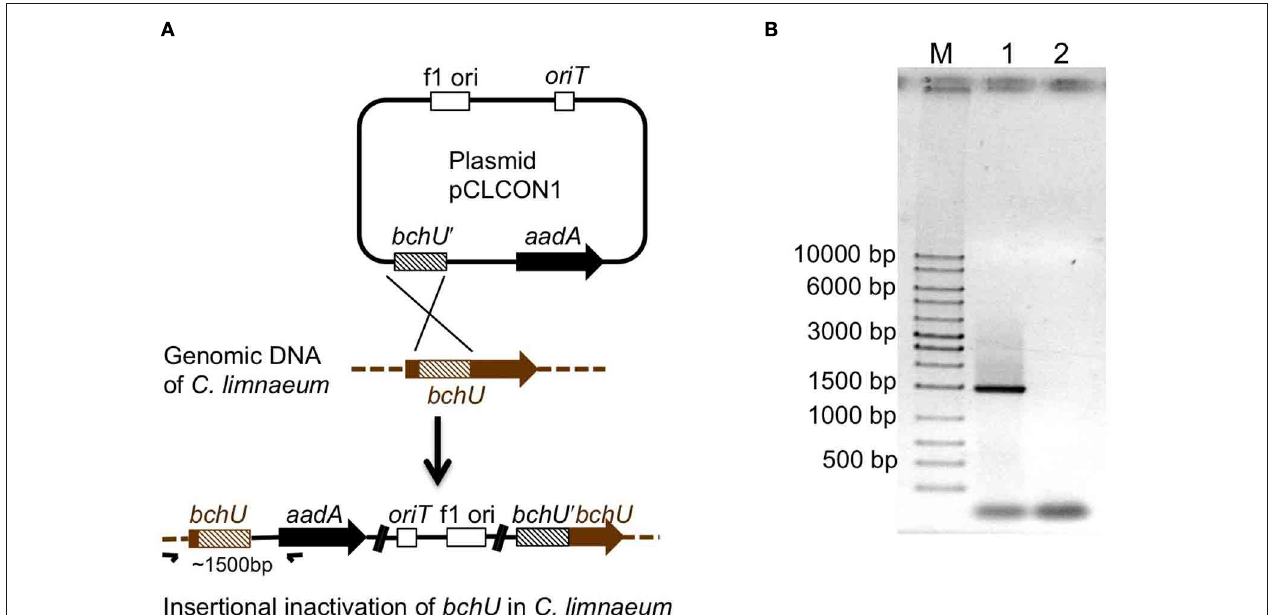
FIGURE 2 | (A) Schemeshowingthegeneralfeaturesandthearrangementin suicideplasmid pCLCON1andhowasinglecross-overrecombinationevent betweenthegene-internalfragmentof bchU ( bchU (cid:2) ) leadsto insertional inactivationof thechromosomal bchU gene. (B) Agarosegelelectrophoresisof PCRproductsto demonstrateinsertionalinactivation ofthe bchU gene.Lanes: